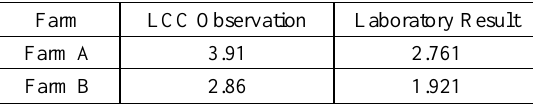
Table 2. Summary of Nitrogen Level in Farms A and B Table 1 shows the summary of N level in Farms A and B.